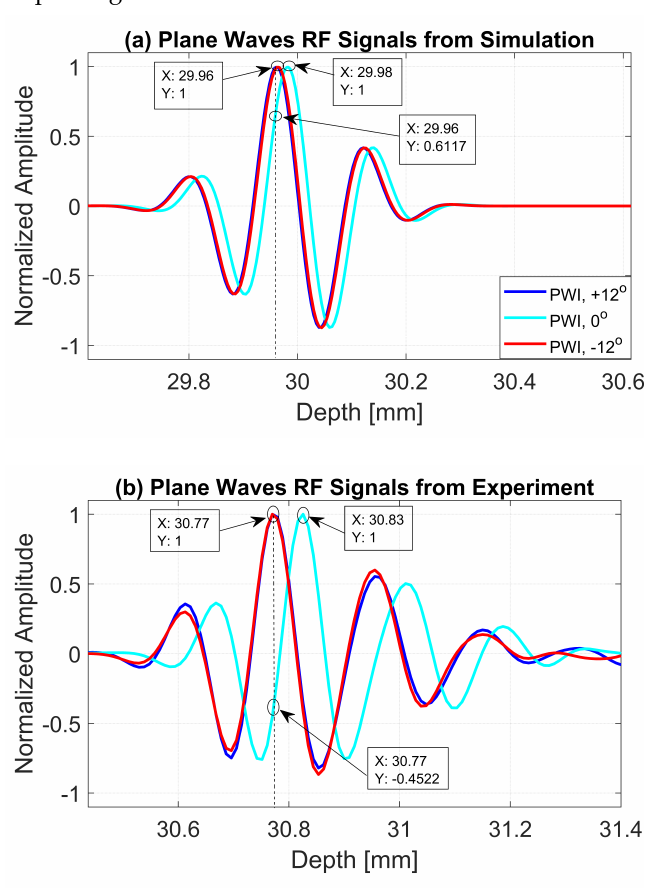
Figure 4. RF signals for the dashed line as shown in Figure 3b from plane waves steered at − 12 ◦ , 0 ◦ and + 12 ◦ with ( a ) Field II simulations and ( b ) experimental measurements.